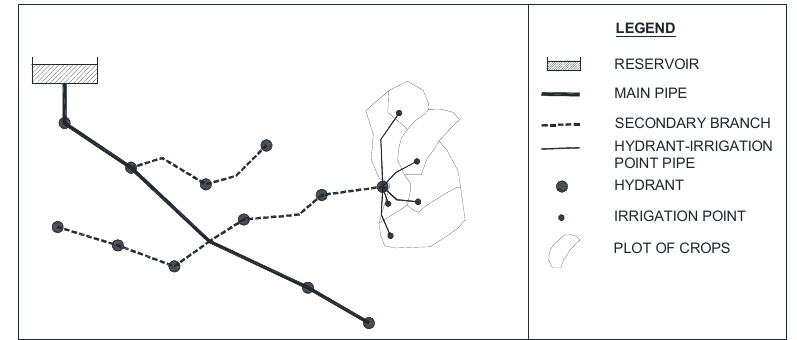
Figure 3. Scheme of irrigation network.